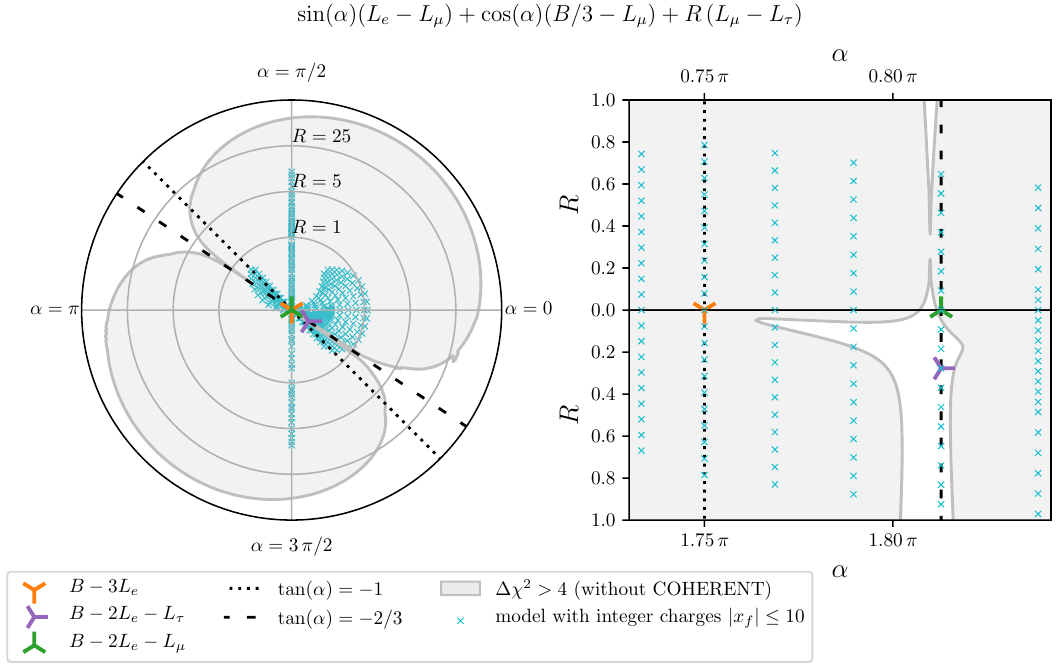
Figure 2 . Bounds on vector-like gauge model solutions to ( g − 2) µ , parameterized by eq. (4.4), at m X = 200 MeV . Inside the grey region, an explanation of ( g − 2) µ is excluded by the combination of data from neutrino oscillations in matter, NA64, Borexino, BaBar 2014 (see text for details). The blue crosses correspond to models with integer charges | x 10 . Linear and logarithmic scales are f | ≤ used for R < 1 and R > 1 ,